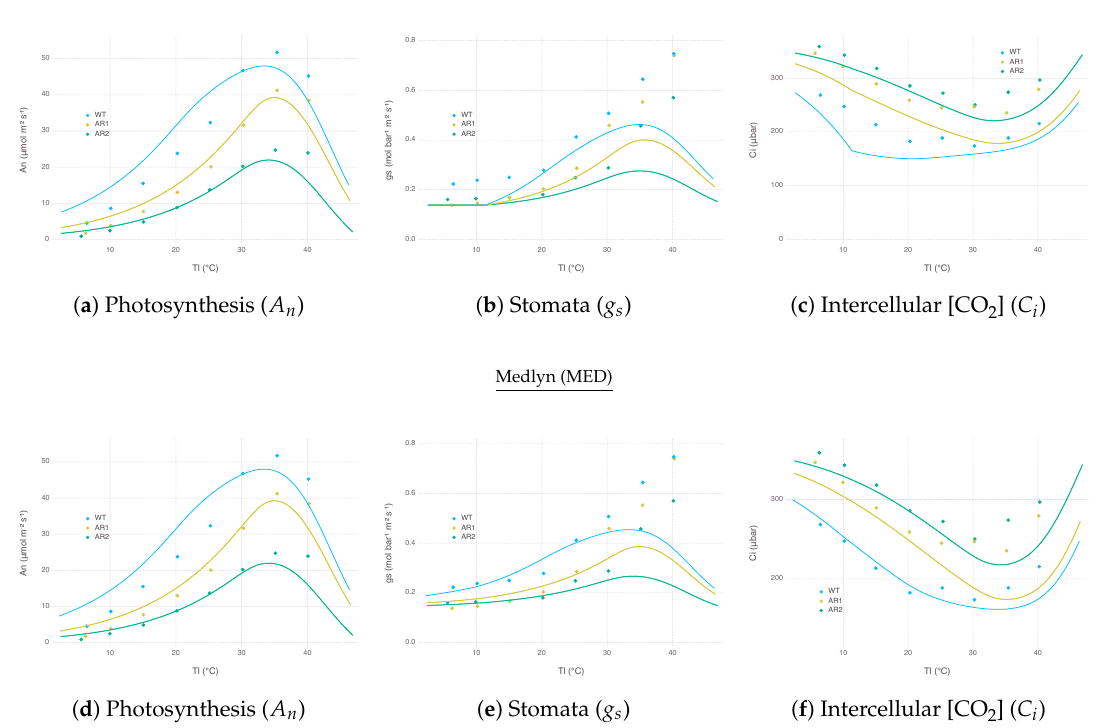
Figure 7. Gas-exchange simulation results over a range of leaf temperature for wild type (WT) and mutants (AR1, AR2) Flaveria bidentis leaves with Rubisco content reduced to 49% and 32%, respectively, to replicate Figure 1 of Kubien et al. [39]. Variables and parameters modified for this simulation are listed in Table A3. Other parameters remained the same as listed in Table A2. Solid curves represent model estimation for each treatment. Dots indicate data points digitized from the result of original